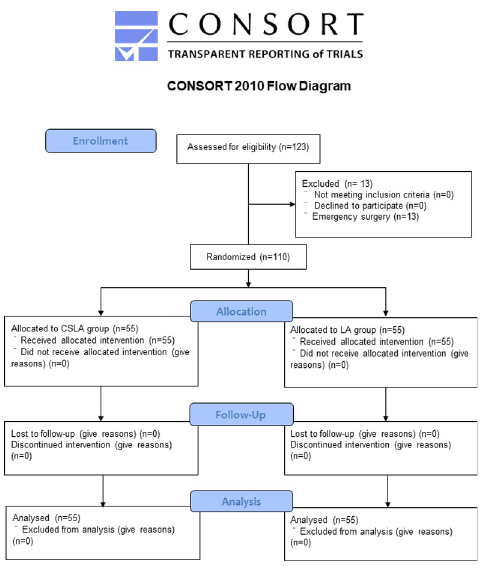
Fig 1. Flowchart of the randomized controlled trial. CSLA, combined short-axis out-of-plane and long-axis in-plane approach; LA, long-axis in-plane approach.